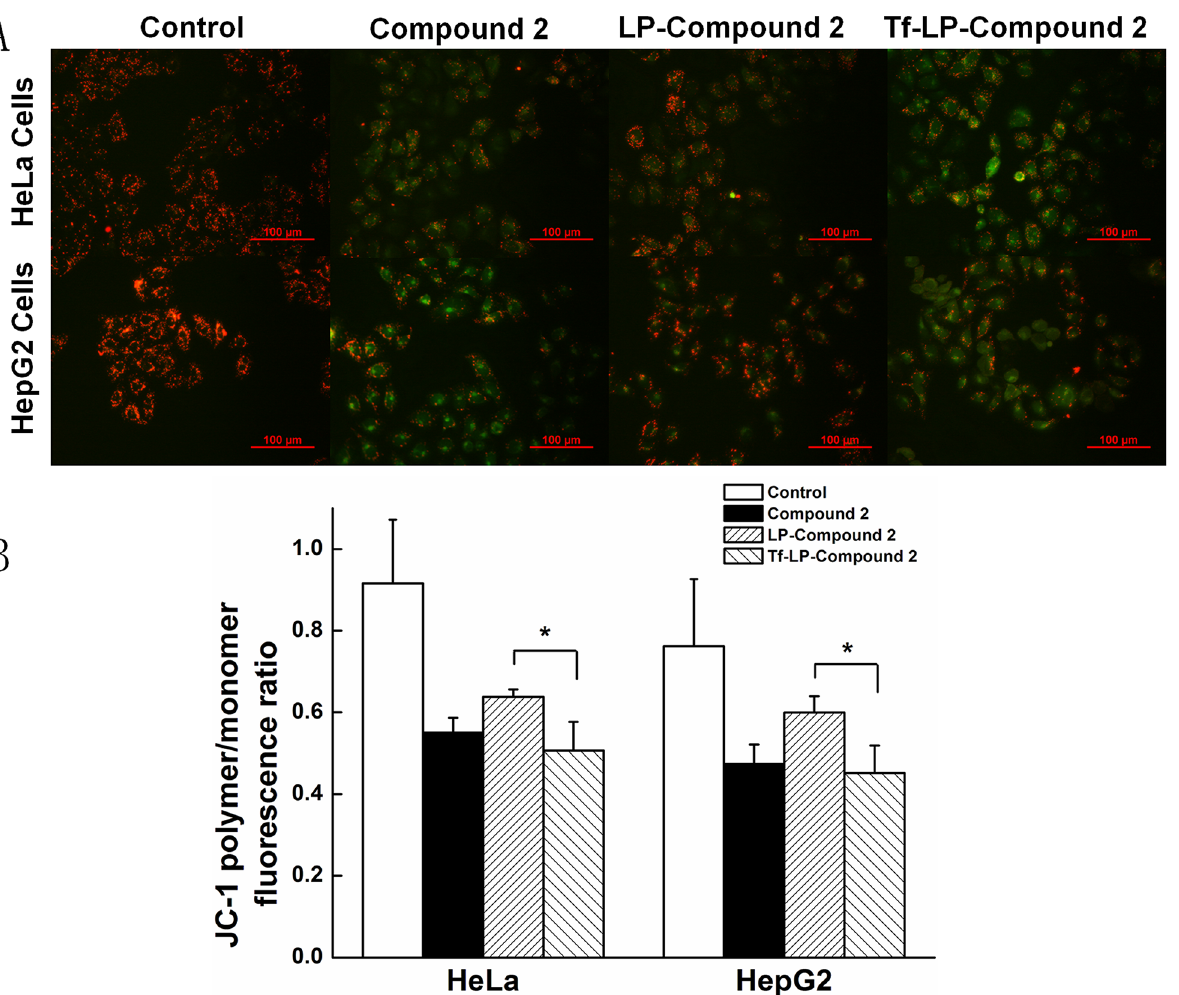
Fig 6. Fluorescence image of HeLa and HepG2 cells stained with JC-1. (A)Photograph showing JC-1 red, JC-1 green and merge image. (B)Numerical data were expressed in terms of the ratio of JC-1 aggregates to JC-1 monomers. Data are representative of three independent experiments and expressed as means ± SD, * p, 0.05, ** p, 0.01 and *** p, 0.001 as compared with the control.